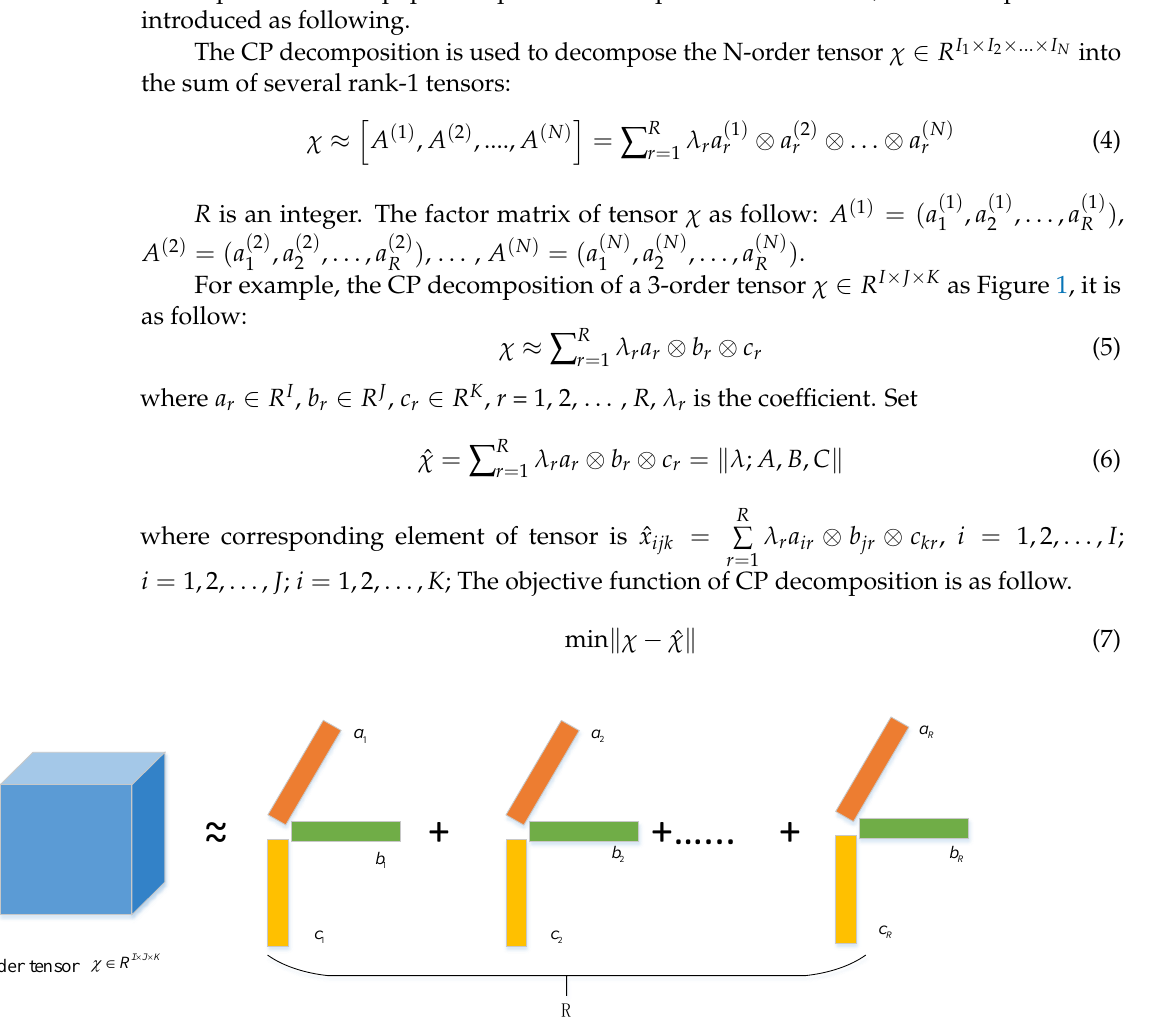
Figure 1. CP decomposition of a 3-order tensor.